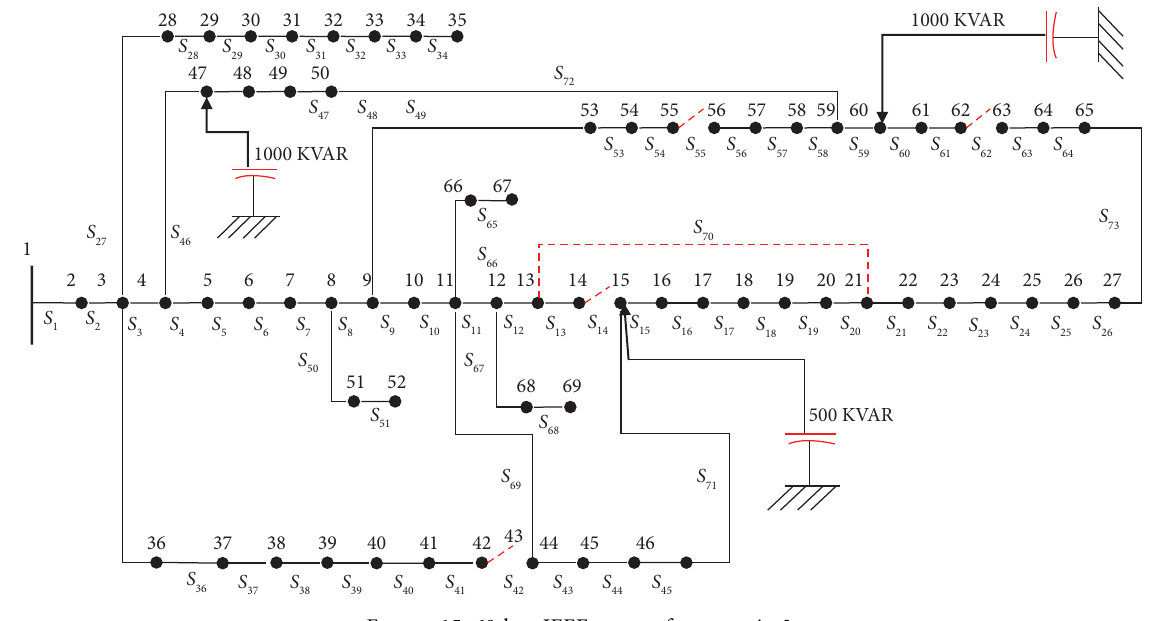
Figure 15: 69-bus IEEE system for scenario 2.